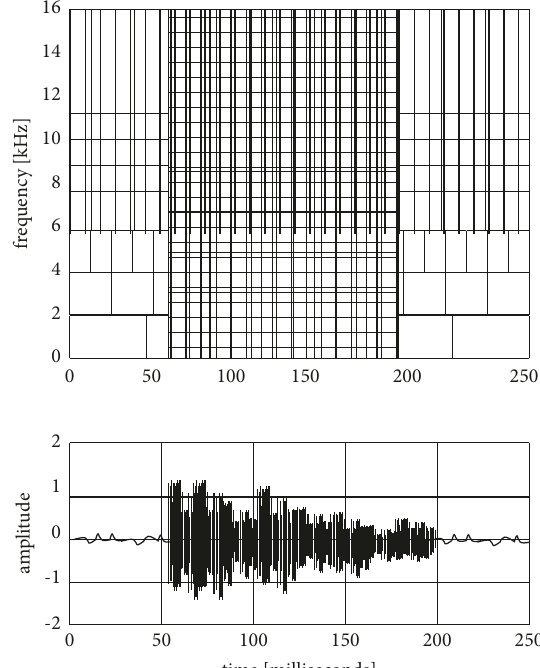
Figure 8: The sudden addition of a drumming sound in a 250ms vocal in the time domain. In the time-frequency analysis, the nonstationary part is first extracted, and then the low-frequency harmonics and the high-frequency envelope are parameterized in the frequency domain.